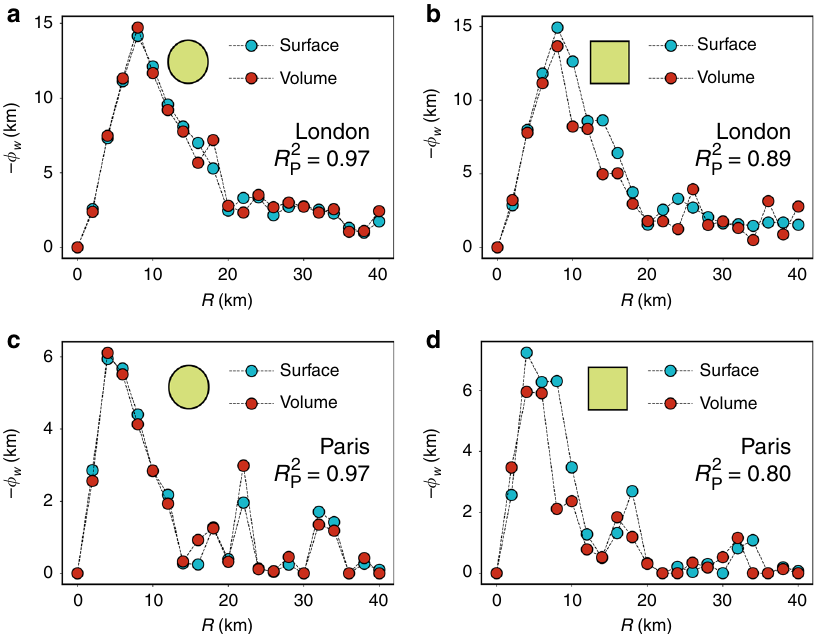
(cid:2) ! obtained from commuters going to work. In red, the volume